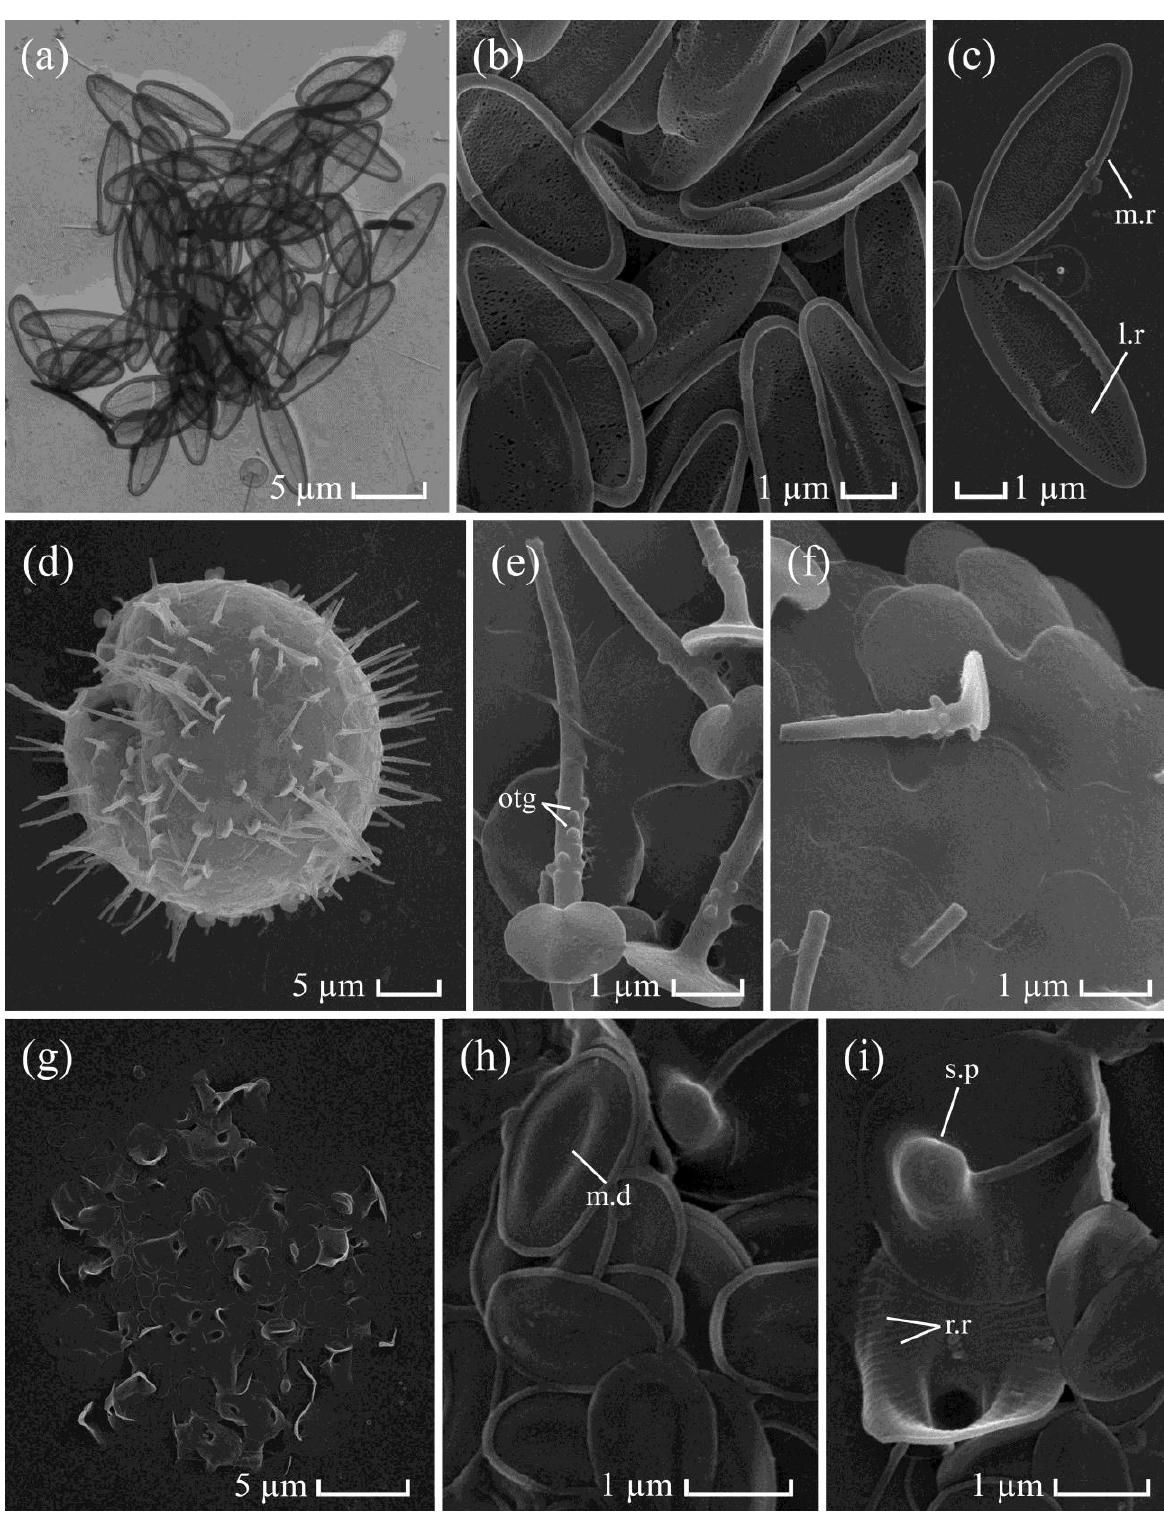
Figure 4. Morphology of observed scales of centrohelid genera Raphidocystis , Choanocystis , Pseudoraphidiophrys , (a) TEM, (b)–(i) SEM. (a)–(c) R. symmetrica : (a) scales of single cell; (b)–(c) plate scales. (d)–(f) C. aculeata : (d) scales of single cell; (e) spine scales; (f) spine and plate scales. (g)–(i) P. veliformis : (g) scales of single cell; (h) plate scales; (c) spine scales. Abbreviations: l.r = longitudinal rim; m.d = medial depression; m.r = marginal rim; otr = outgrowths; r.r = radial ribs; s.p = subapical